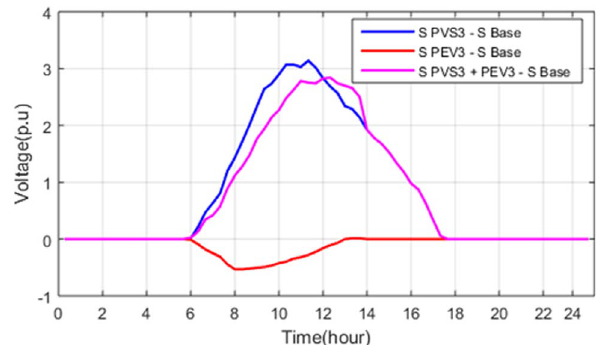
Figure 11. Analysis of system THD differences in maximum level during summer.